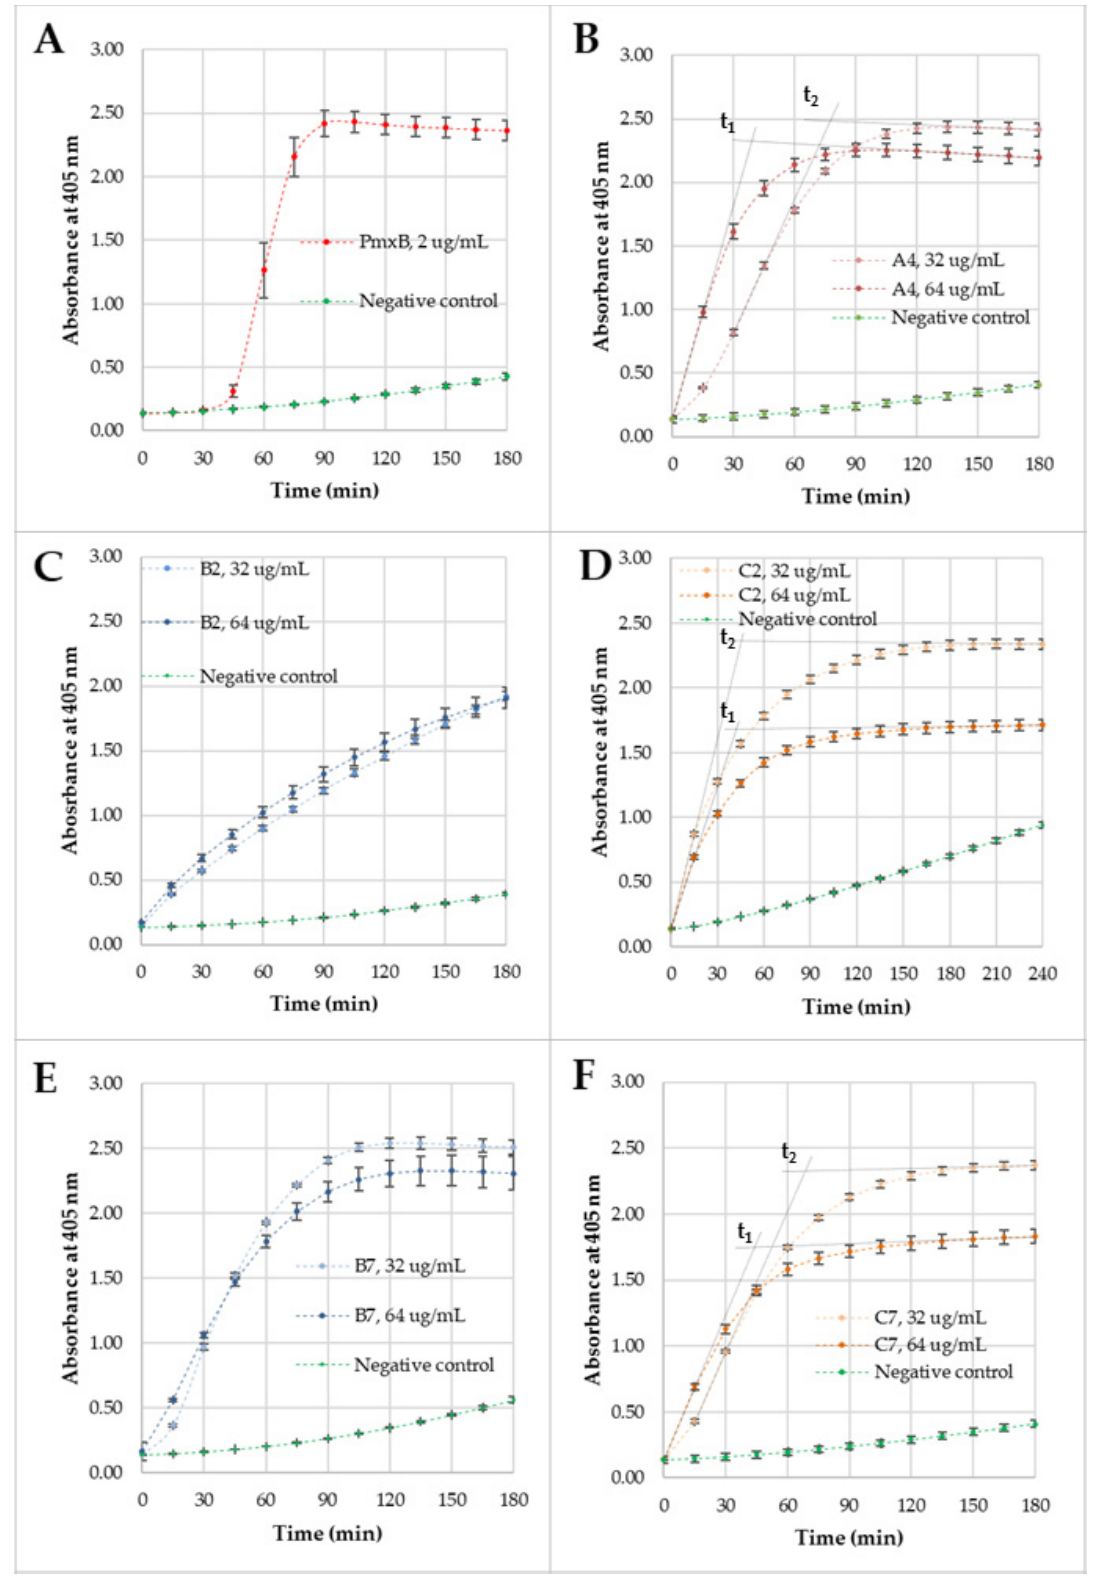
Figure 11. Inner membrane (IM) permeabilization kinetics. ( A ) Polymyxin B at 2 µg/mL; ( B ) A4 at 32 and 64 µg/mL; ( C ) B2 at 32 and 64 µg/mL; ( D ) C2 at 32 and 64 µg/mL; ( E ) B7 at 32 and 64 µg/mL; ( F ) C7 at 32 and 64 µg/mL.